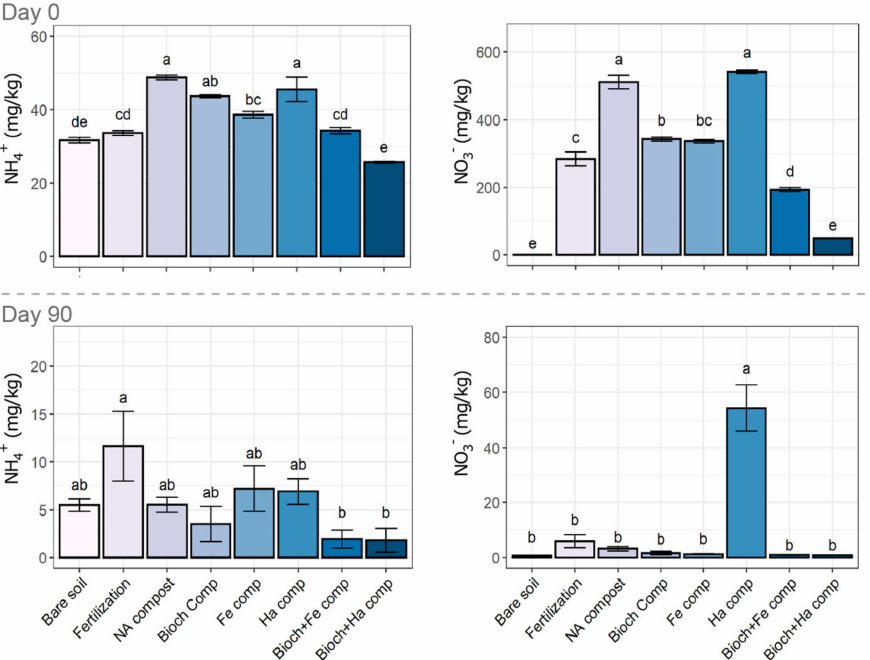
Figure 2. Mineral forms of nitrogen (NH 4+ and NO 3 − ) of the different treatments at the beginning and finish of the greenhouse experiment (day 0 and 90). Lower-case letters indicate significantly different means at p <